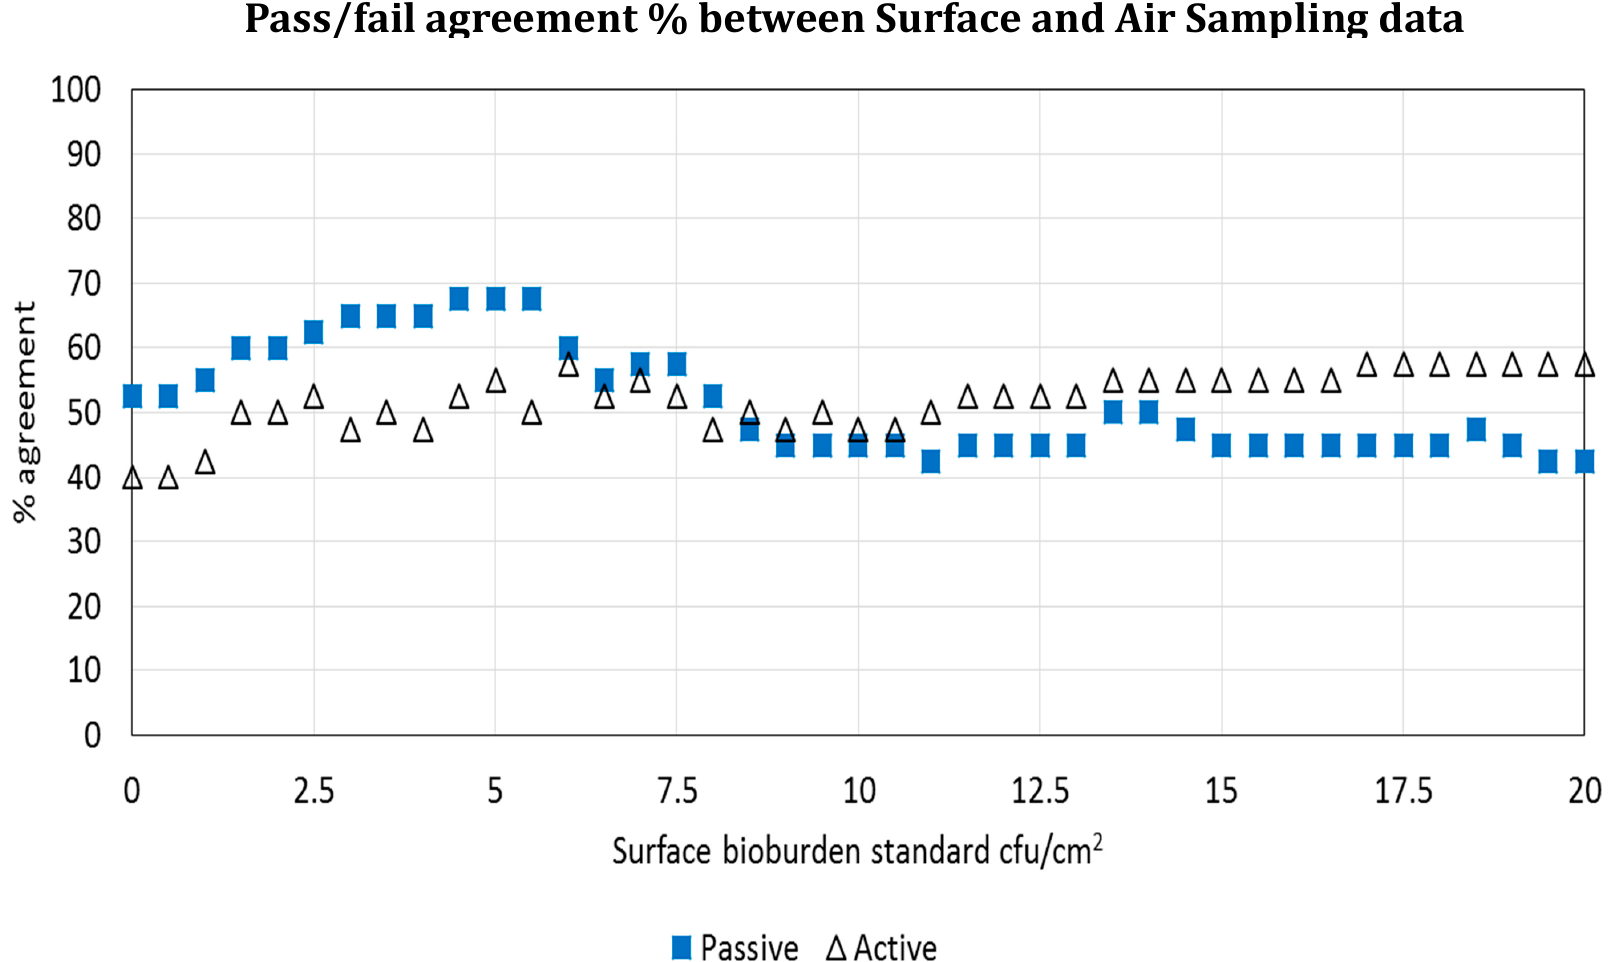
Figure 3. Is surface bioburden associated with air bioburden? Agreement between active and passive air sampling and surface bioburden using a range of surface standards from 0–20 cfu / cm 2 . The X axis shows the percentage pass or fail agreement between active and passive air data for each bioburden standard; the Y axis shows the surface bioburden value in cfu / cm 2